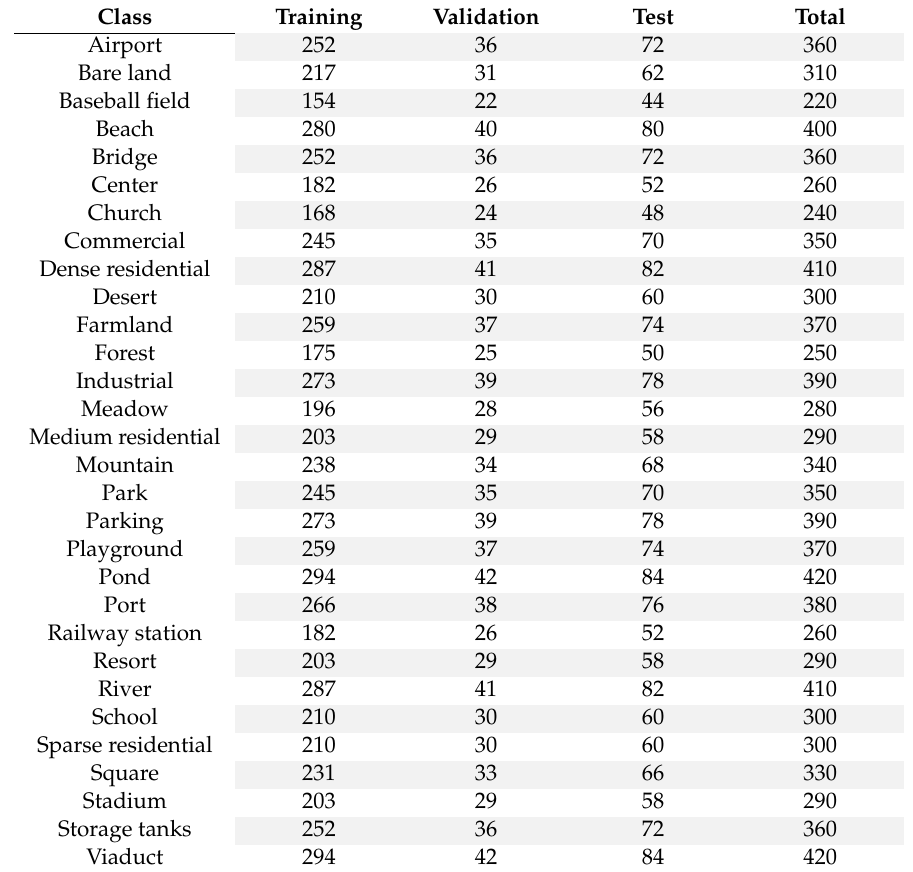
Table 2. Number of samples for training, validation, and test used for the Aerial Image Dataset